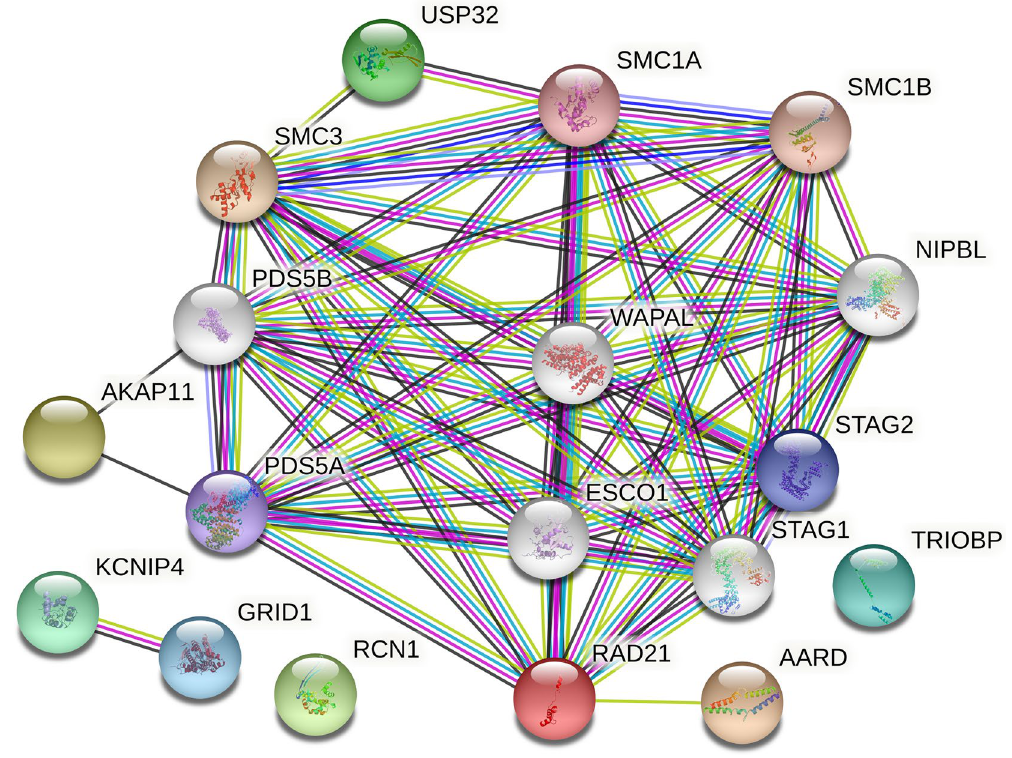
Figure 3. STRING analysis identified a connected network linking USP32, AKAP11, and AARD to the cohesin proteins including RAD21. Additionally, two genes in this study have been shown to be co-expressed ( KCNIP4 and GRID1 ; RNA co-expression score =